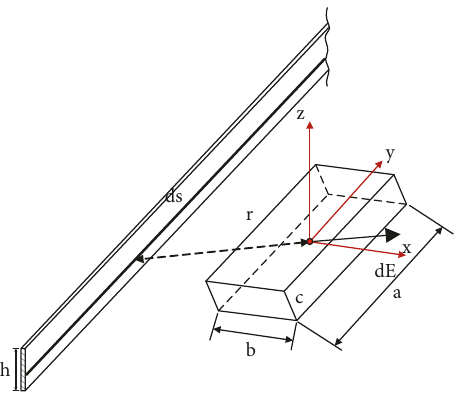
Figure 2: Simplified vehicle and coordinate system.